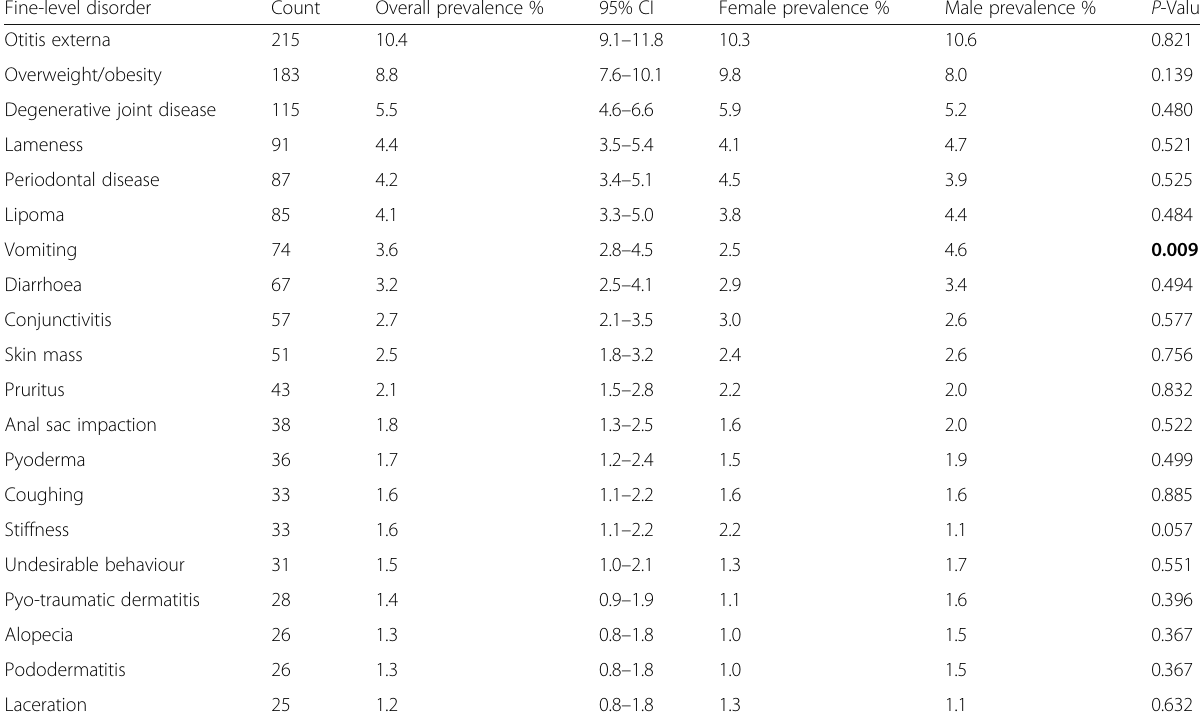
Table 3 Prevalence of the most common disorders at a fine-level of diagnostic precision recorded in Labrador retrievers ( n = 2074) attending UK primary-care veterinary practices participating in the VetCompass ™ Programme from January 1st, 2013 to December 31st, 2013 Fine-level